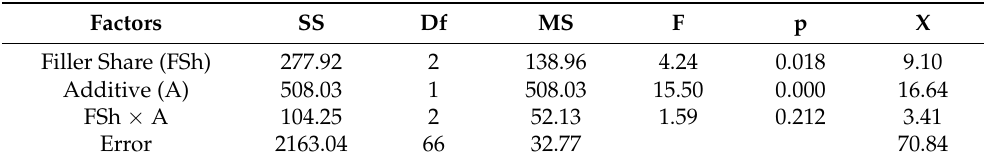
Table 7. Analysis of variance for selected factors and interactions between the factors influencing the axial force during drilling HDPE-based composite with addition of